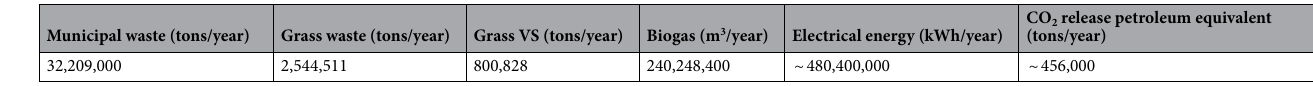
Table 4. Biogas, electricity and CO 2